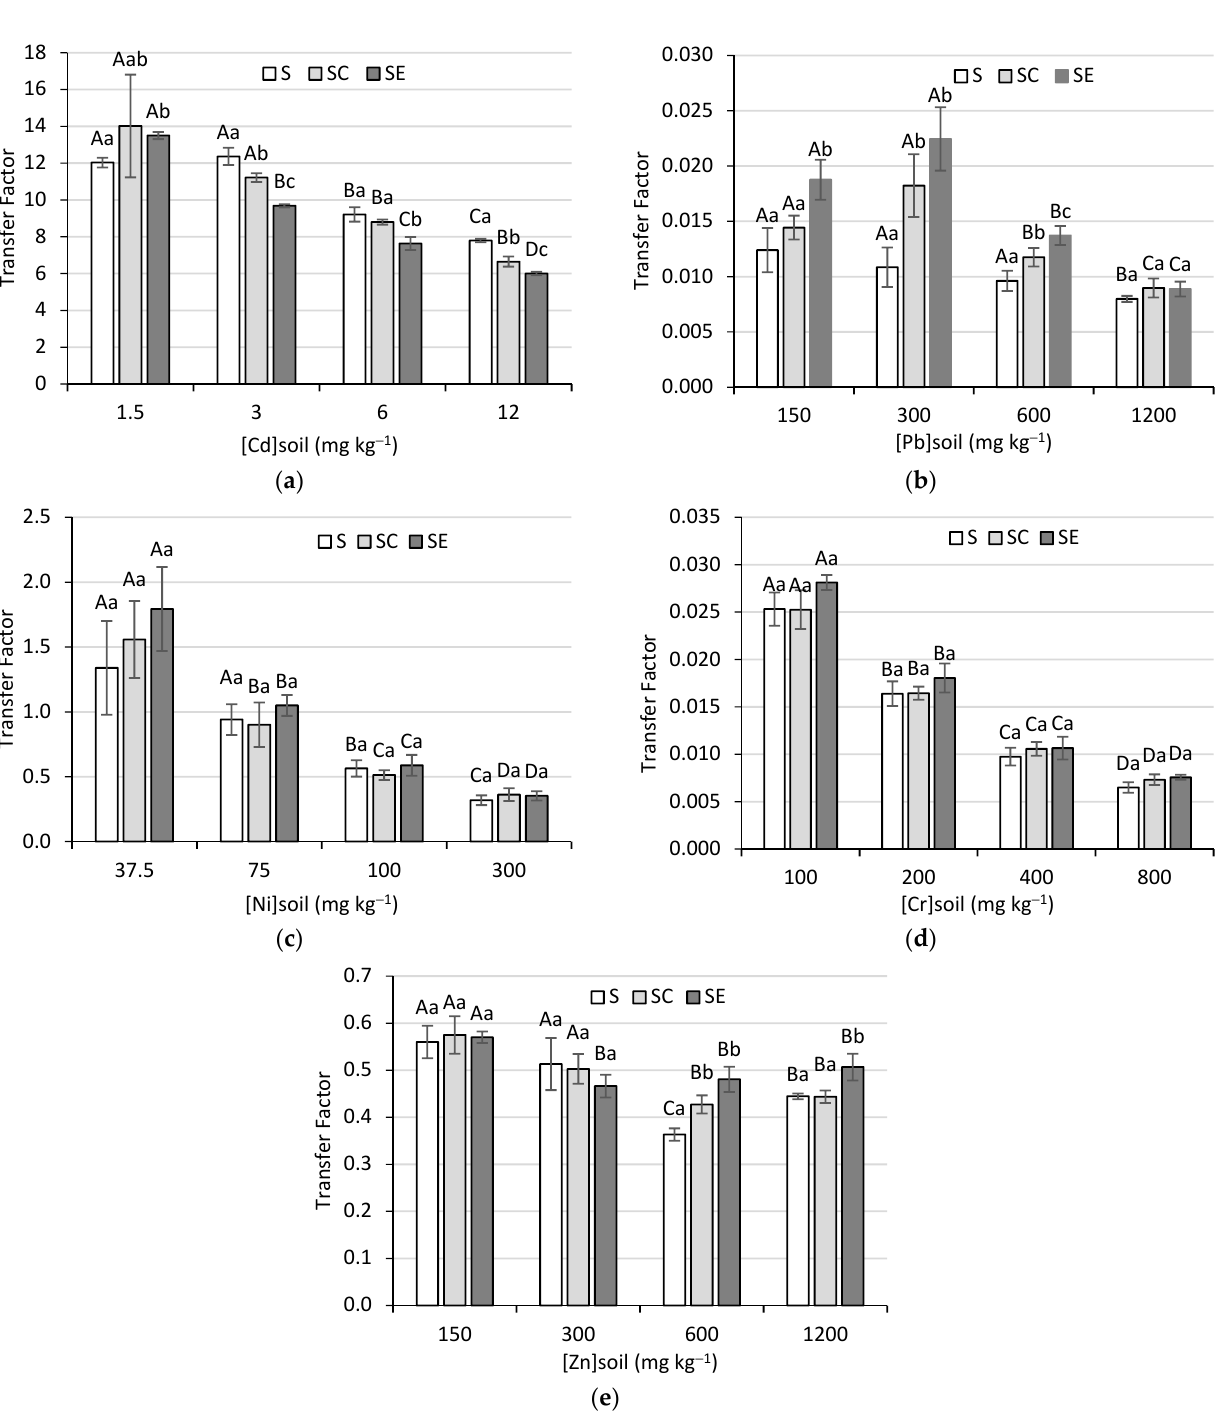
Figure 2. Transfer factor (TF) for each PTE and each treatment, non-amended soil (S), soil amended with cork powder (SC) and soil amended with horse manure (SE): ( a ) Cd; ( b ) Pb; ( c ) Ni; ( d ) Cr; ( e ) Zn.